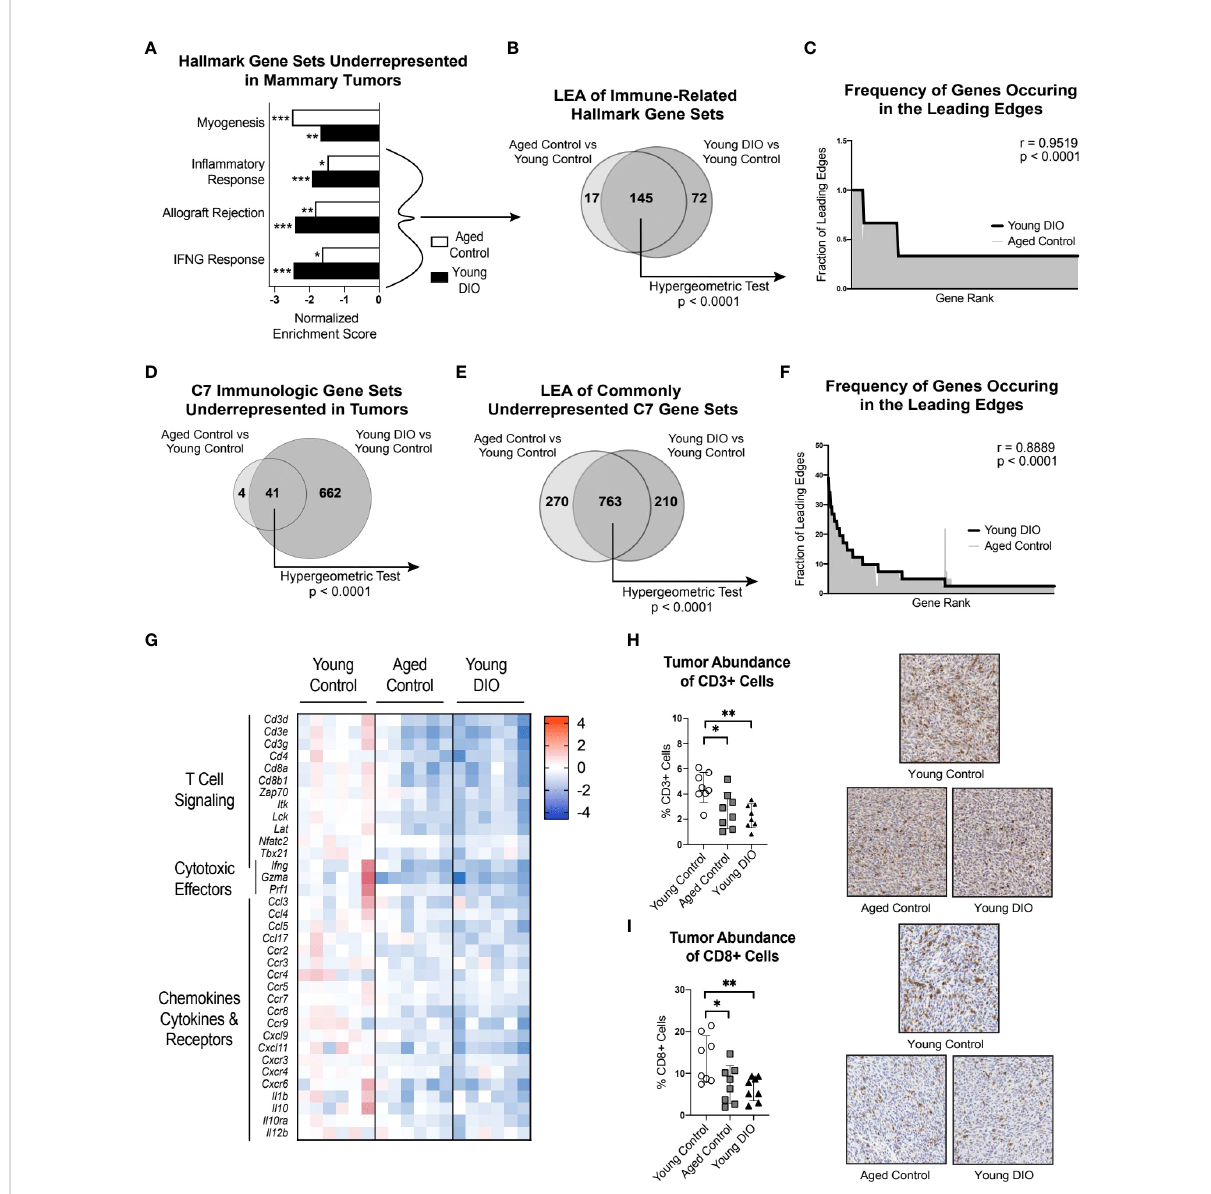
FIGURE 3 Advanced age and DIO promote immunosuppression within the tumor microenvironment and decreased CD8 T cell surveillance. (A) Hallmark gene sets commonly underrepresented in mammary tumors of aged control versus young control and young DIO versus young control mice determined following gene set enrichment analysis (GSEA). (B) Leading edge analysis (LEA) of immune-related Hallmark gene sets commonly underrepresented. (C) Frequency of genes occurring in the leading edge of commonly underrepresented, immune-related Hallmark gene sets versus gene rank. (D) C7 Immunologic gene sets commonly underrepresented in mammary tumor of aged control versus young control and young DIO versus young control mice determined following GSEA. (E) LEA of all C7 gene sets commonly underrepresented. (F) Frequency of genes occurring in the leading edge of underrepresented C7 gene sets versus gene rank. (G) Heat map of select leading edge genes. (H) Percentage of cells stained positive for CD3 and (I) CD8 analyzed using QuPath and presented as mean ± SD. Signi fi cantly enriched gene sets de fi ned as FDR q-value <0.05. Signi fi cance in overlap of leading edge genes analyzed using hypergeometric test. Correlation between the gene rank of leading edge contributors calculated by the Spearman test. Immunohistochemical staining analyzed relative to young control using one-way ANOVA and Dunnet post hoc test. Asterisks denote signi fi cance: *< 0.05, **< 0.01, ***<